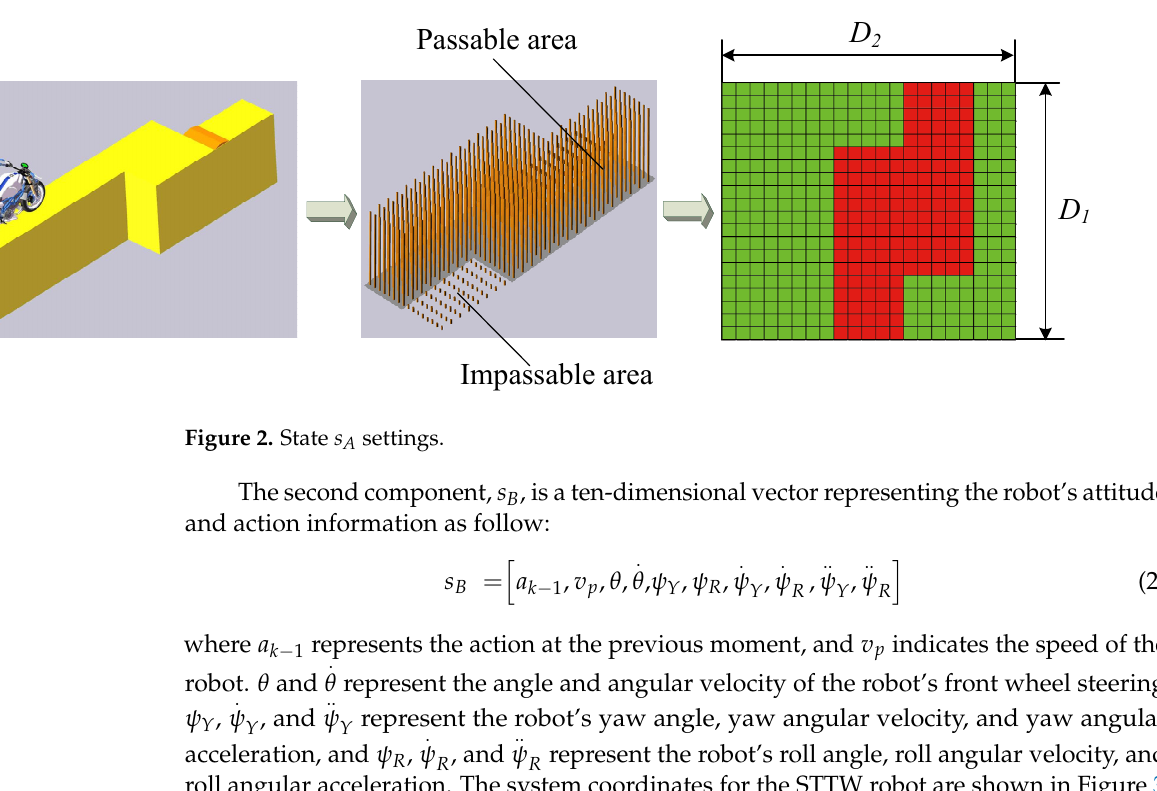
represent the robot’s roll angle, roll